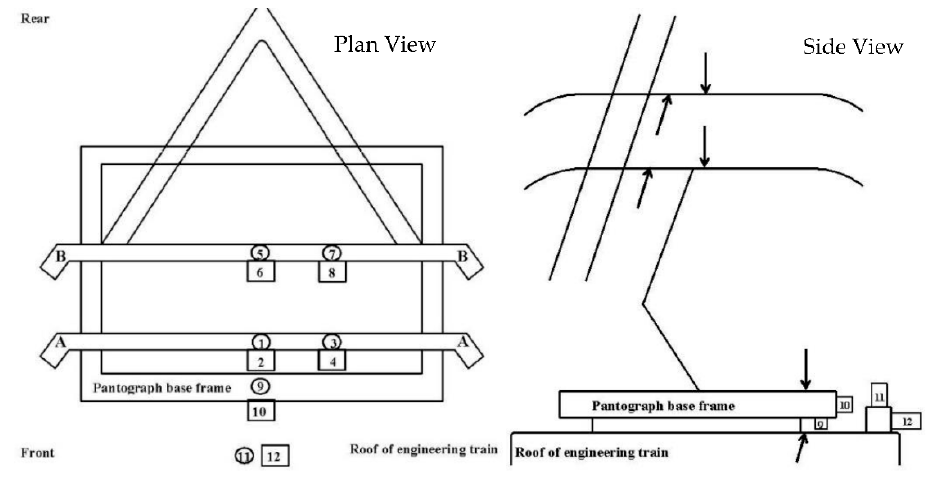
Figure 18. Field test set-up.